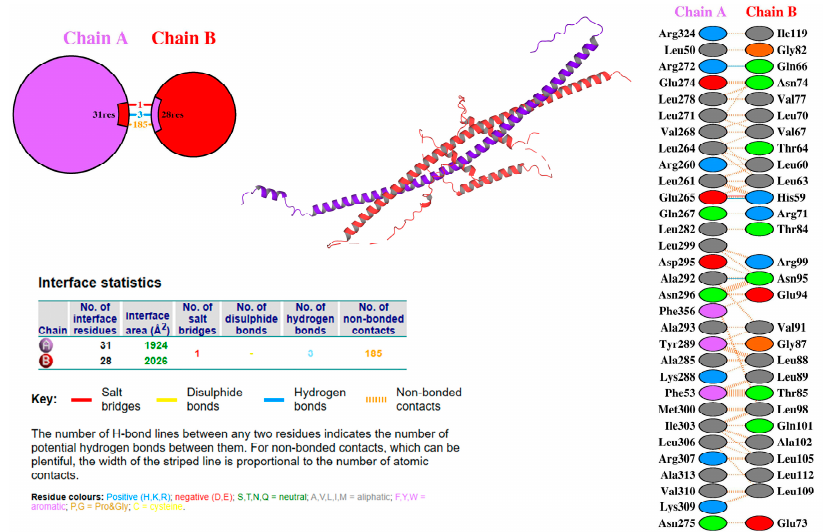
Figure 7. PDBSum tool analysis result of the interaction between OsbZIP14 and OsbZIP58 products. To further confirm the direct interaction between OsbZIP14 and OsbZIP58 products, the ORFs of OsbZIP14 and OsbZIP58 were cloned by PCR to generate the vectors N-OsbZIP58/C, N/C-OsbZIP14, and N-OsbZIP58/C-OsbZIP14 (Figure 8). The control was a mixture of C-OsbZIP14, N-OsbZIP58, and the corresponding empty plasmids, while the treatment group was a mixture of the pRTVnVC-OsbZIP14 and pRTVnVN-OsbZIP58 plasmids. The corresponding plasmids were then transferred into rice protoplasts, and the results were observed with a laser confocal system after 9 h culture. The red and green lights confirmed that both plasmids were successfully transferred into the protoplasts. The yellow light was observed in the treated samples, indicating a direct interaction between OsbZIP14 and OsbZIP58 proteins in rice, whereas the control group did not show any yellow light.